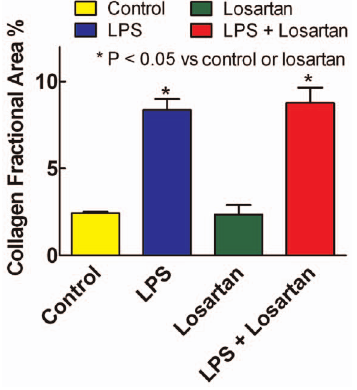
Figure 10. LPS increased IL-6 expression in isolated adult cardiac fibroblasts. Isolated adult cardiac fibroblasts were exposed to vehicle or LPS in concentrations of 0.1, 1.0, or 10 ng/ml for 48 hours. There was a dose dependent increase in IL-6 (P , 0.001, ANOVA, each bar mean + SEM, n=4). All LPS doses were higher than control and increased significantly with each increment in dose (P , 0.05). LPS caused no significant change in TGF- b .